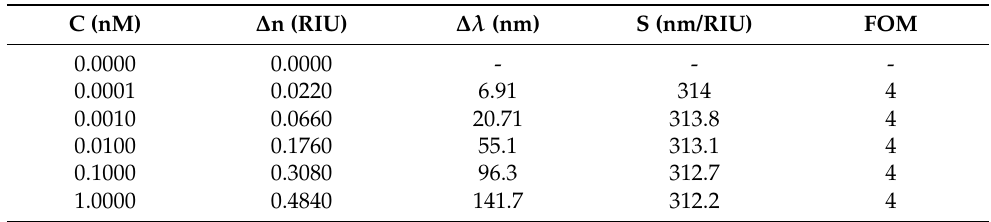
Figure 8. ( a ) Extinction as a function of wavelength for different concentrations of the SARS-CoV-2 S-glycoprotein solution. ( b ) The wavelength shift as a function of concentration. Table 1. The performance parameters of the proposed biosensor for different concentrations of the SARS-CoV-2 S-glycoprotein